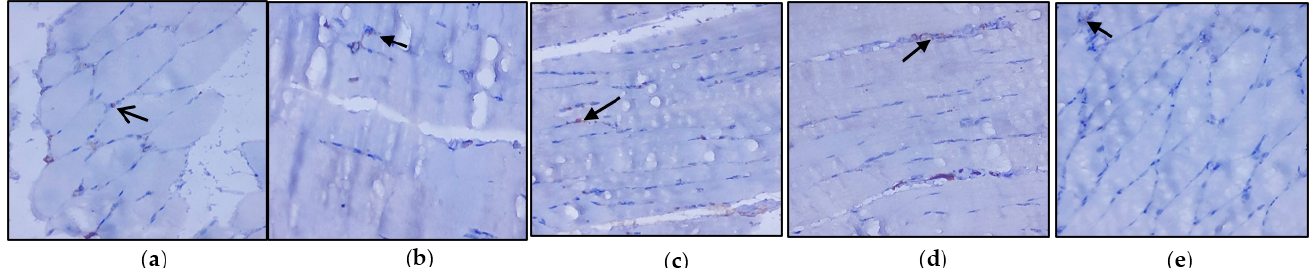
Figure 4. Protein expression of IRS-1 using an immunohistochemical assay (magnification: × 100): ( a ) control rats; ( b ) type 2 diabetic rats; ( c ) type 2 diabetic rats treated with C. papaya (600 mg/kg b.wt); ( d ) type 2 diabetic rats treated with metformin (50 mg/kg, b.wt); ( e ) control rats treated with C. papaya (600 mg/kg b.wt).